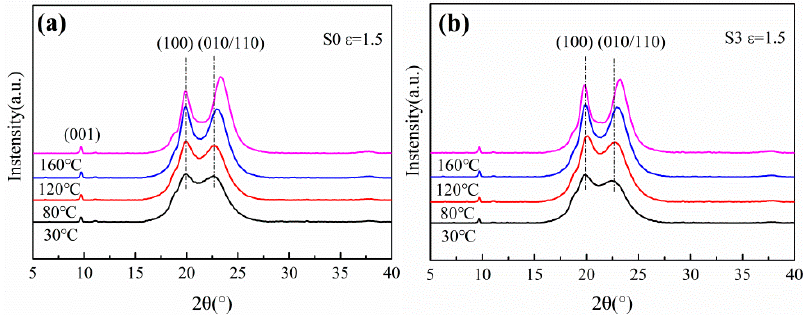
Figure 4. The WAXD curves of ( a ) PA612 and ( b ) PA612/SiO 2 films uniaxially stretched at different temperature. Figure 5. The WAXD curves of uniaxially stretched ( a ) PA612 and ( b ) PA612/SiO 2 films at different strain.